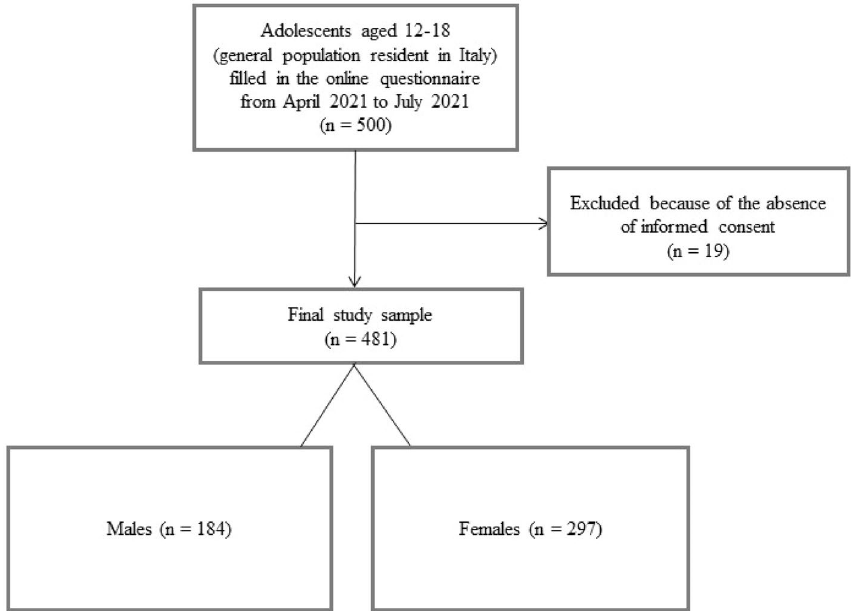
Figure 1. Flow chart of the study